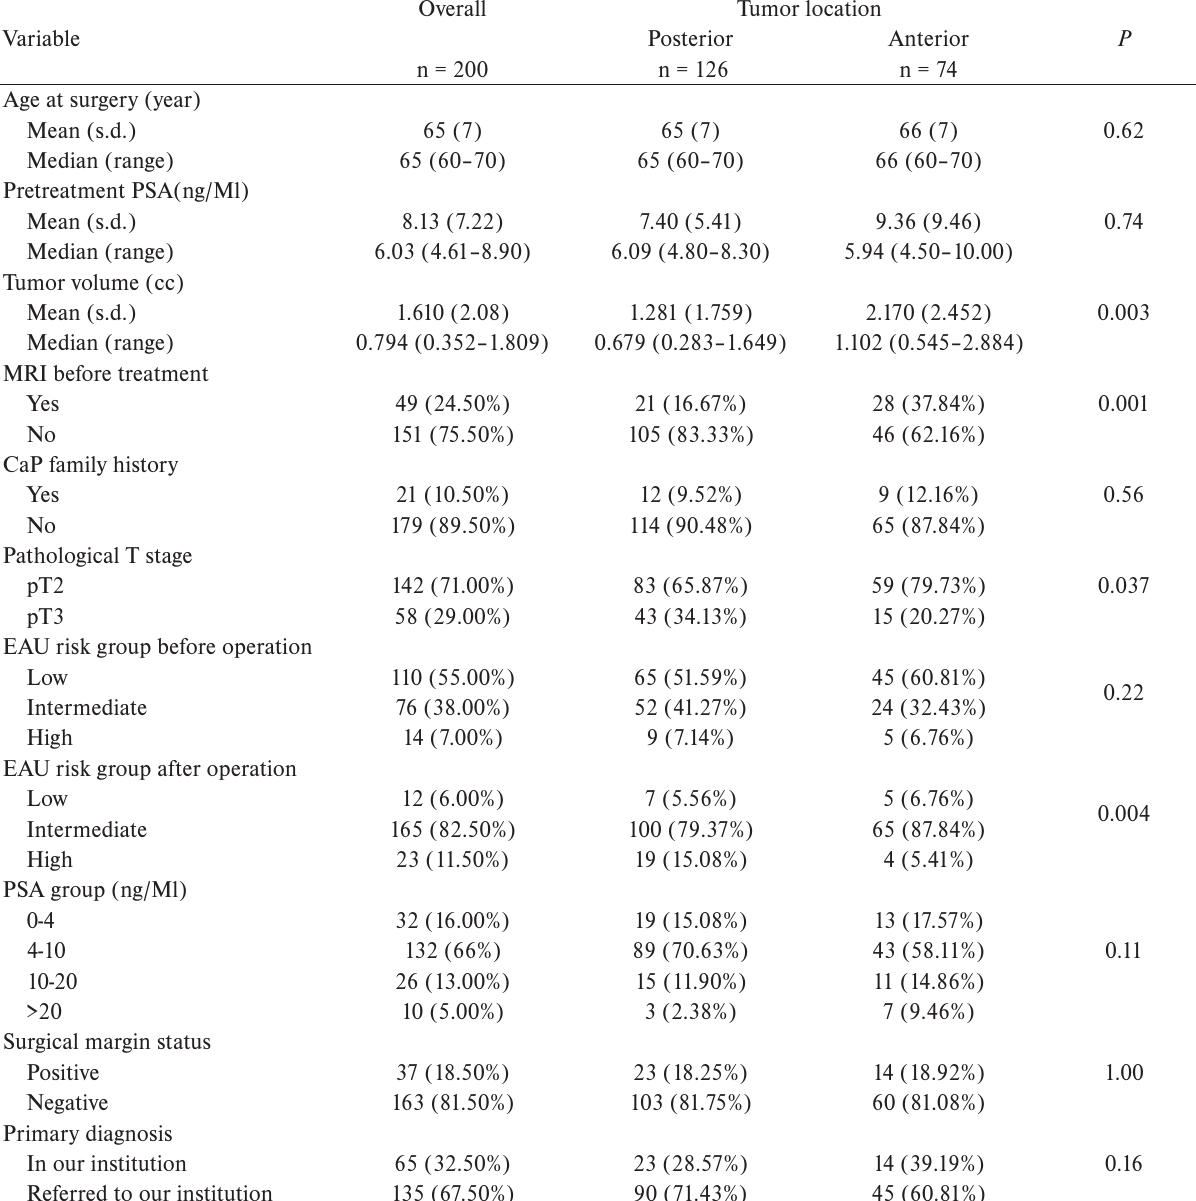
Table 1. Demographic and clinicopathological comparison of anterior vs posterior tumor